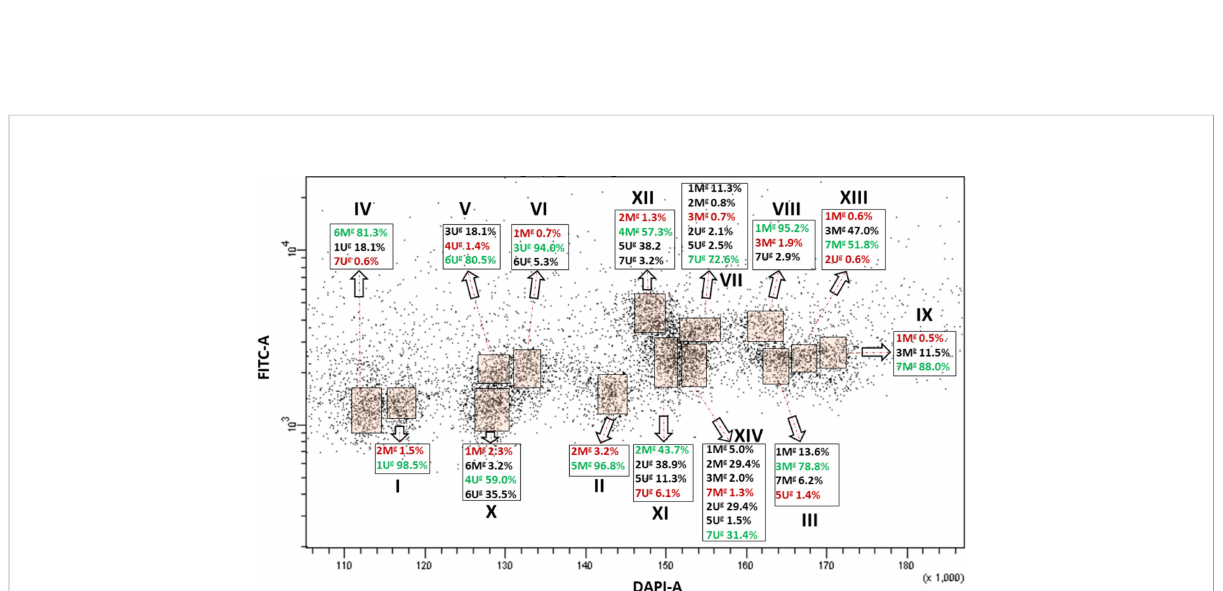
FIGURE 3 Bivariate fl ow karyotype (DAPI-A vs. FITC-A) obtained after FISHIS with the GAA 7 probe on chromosomes isolated from Ae. geniculata acc. AE1311/00. The analysis permitted discrimination of fourteen chromosome populations (orange boxes) representing the whole genome of the species. The red and green numbers within a group of chromosomes sorted together refer to the lowest and highest purities, respectively. x- axis, relative DAPI fl uorescence; y-axis, relative GAA 7 -FITC fl uorescence.